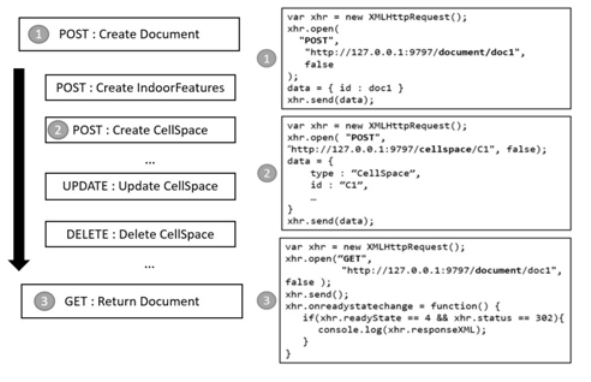
Figure 9. The process of sample program